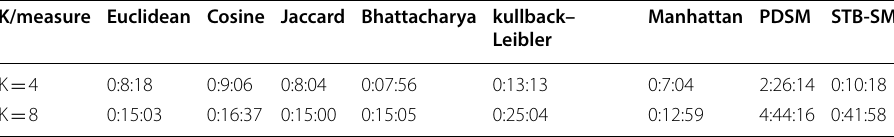
Table 21 Reuters–run time in (hour: minute: second) K/measure Euclidean Cosine Jaccard Bhattacharya kullback–